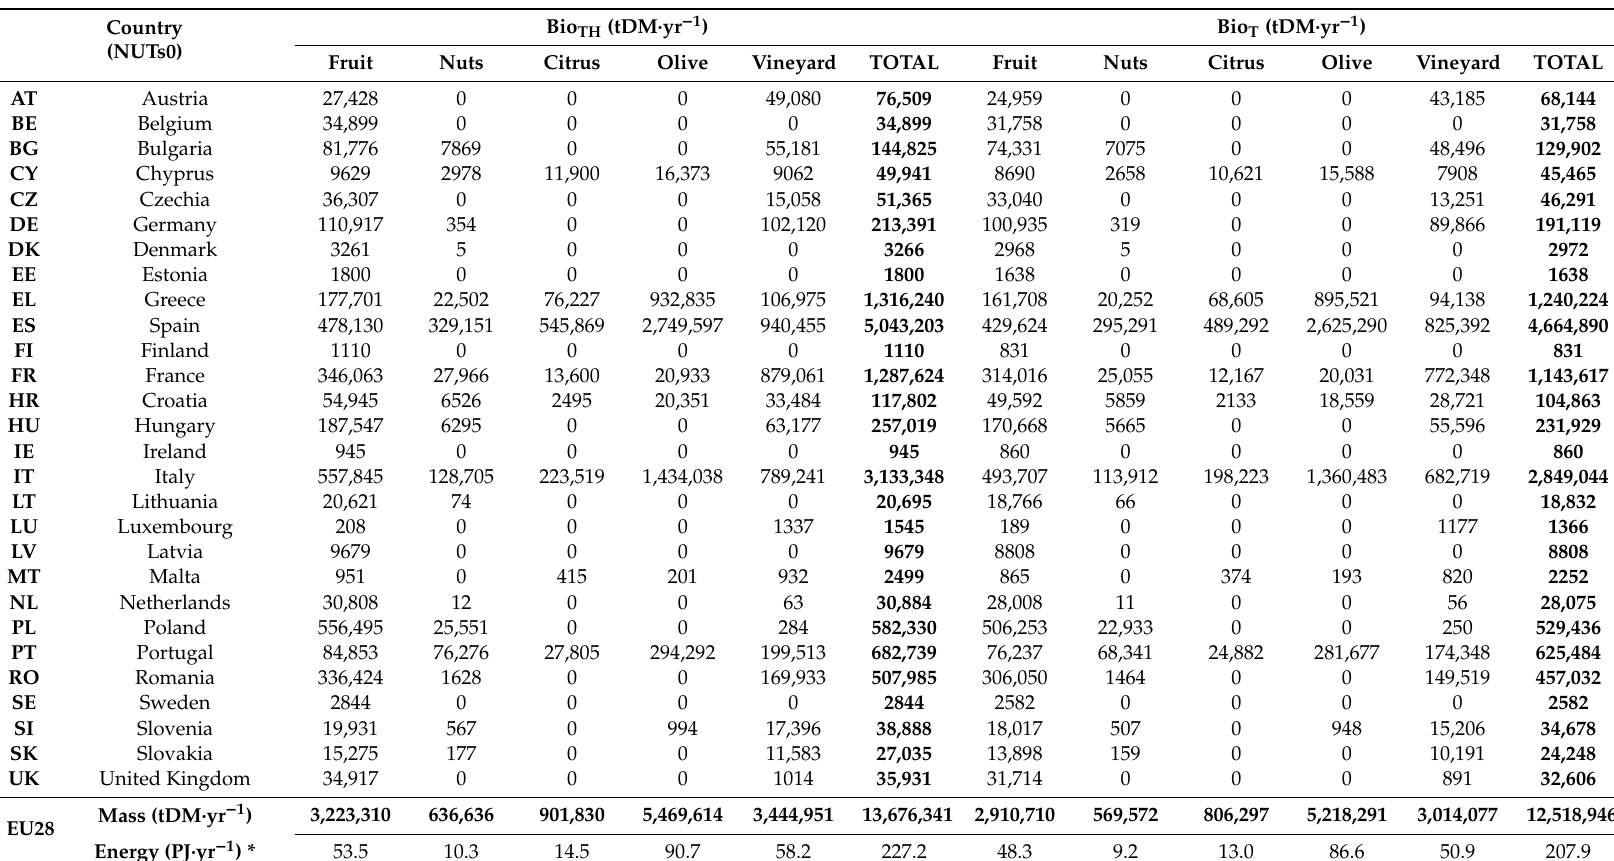
Table 6. Theoretical and technical biomass potential by crop group at NUTs0 (country level) in EU28 (mass and energy units). Country